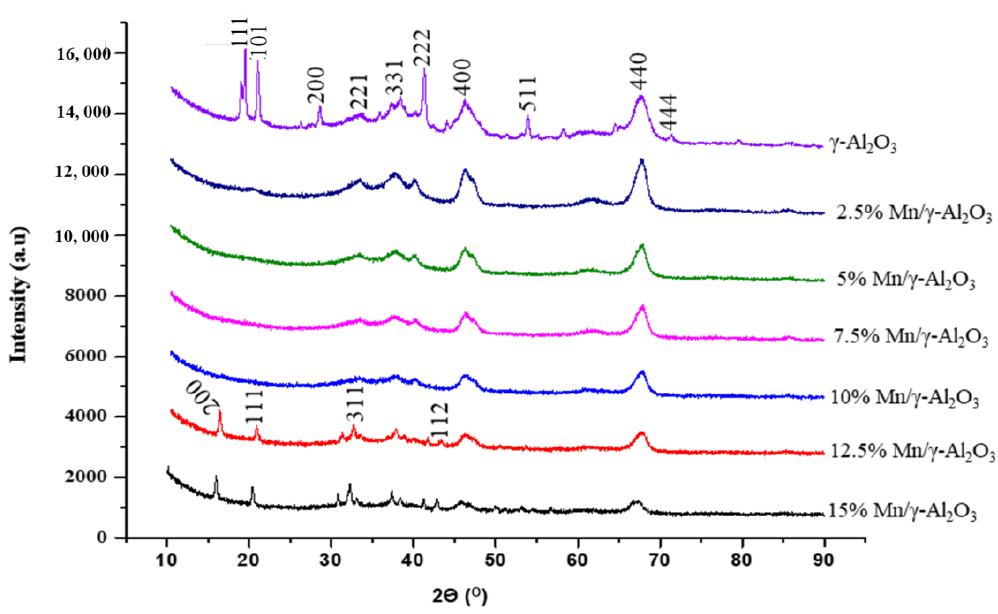
Figure 2. XRD patterns of γ -Al 2 O 3 and various percentages of Mn / γ -Al 2 O 3 catalysts.